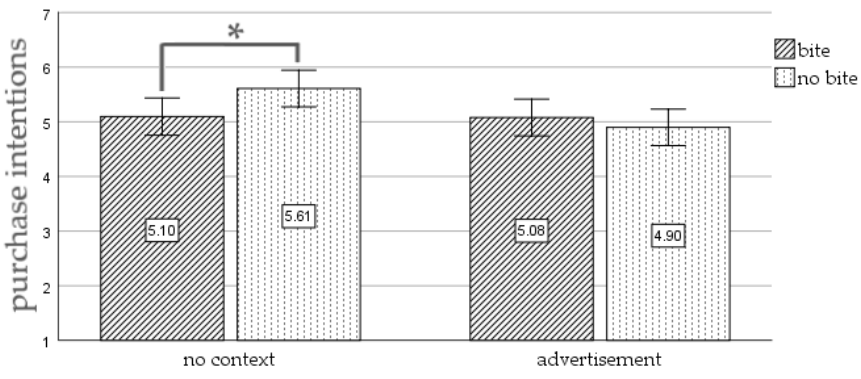
Figure 5. Results of Study 2. The interaction of picture type and context on purchase intentions. Note: * significant at p < 0.05; error bars represent 95% confidence interval.